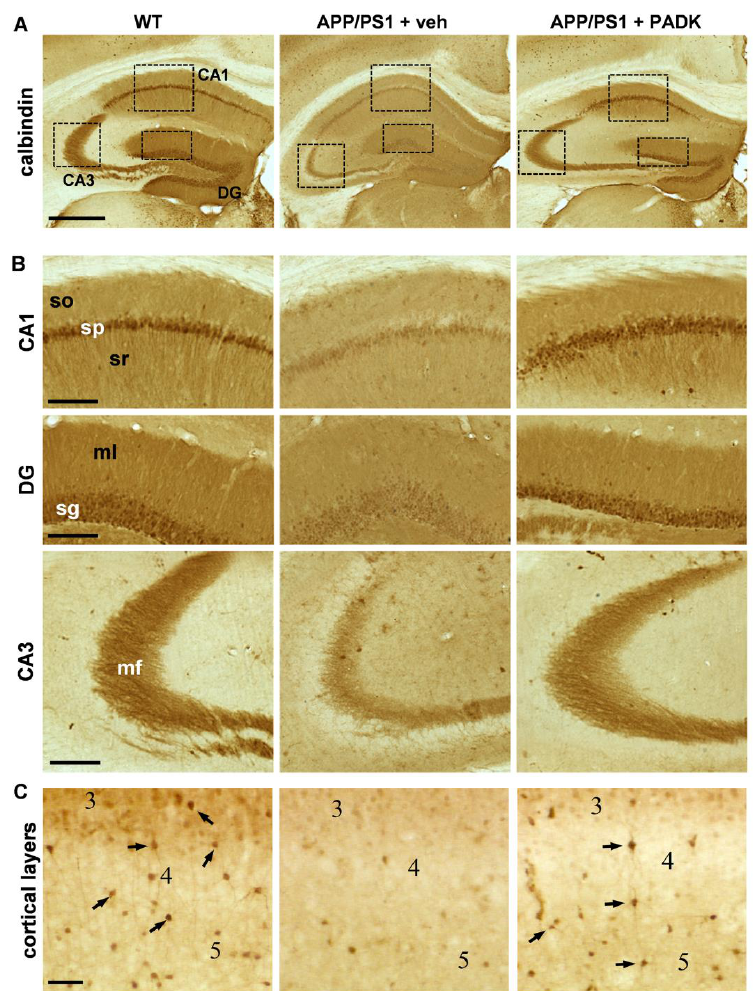
Figure 4. APP/PS1 transgenic mice treated with PADK exhibit restored calbindin immunostaining. Wild-type mice (WT) alongside vehicle- and PADK-treated APP/PS1 mice were assessed by immunohistochemistry in order to visualize calbindin D28k distribution in the hippocampus ( A ; size bar: 500 µm). The boxed areas of the different subfields in A are shown at higher magnification ( B ; size bar: 100 µm), as are interneurons (arrows) immunolabeled in cortical layers 3 – 5 ( C ; bar size: 50 µm). DG, dentate gyrus; mf, mossy fibers; ml, molecular layer; sg, stratum granulosum; so, stratum oriens; sp, stratum pyramidale; sr, stratum radiatum.